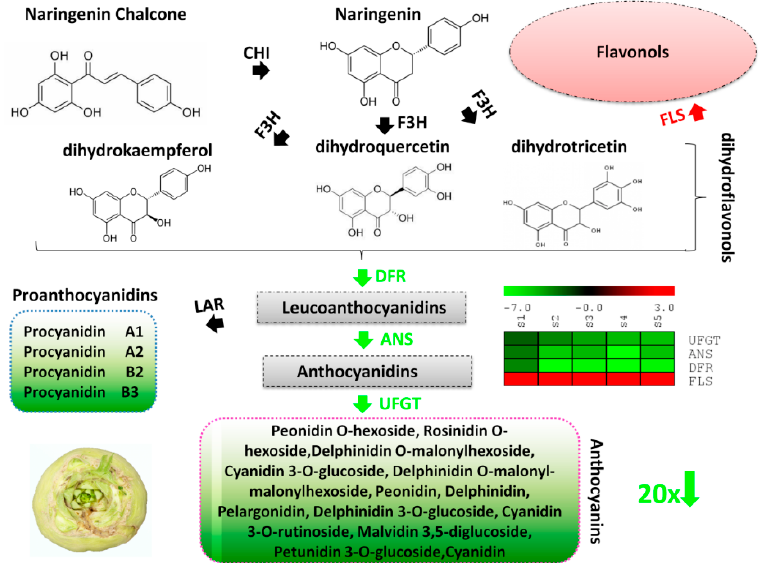
Figure 6. Proposed model of the mechanism leading to the low anthocyanin content in the green turnip (GT). Naringenin chalcone is isomerized by chalcone isomerase (CHI) to naringenin. Flavanone 3-hydroxylase (F3H) converts naringenin into dihydroflavonols (dihydrokaempferol, dihydroquercetin or dihydrotricetin). Then, the three dihydroflavonols are converted into colorless leucoanthocyanidins by dihydroflavonol 4-reductase (DFR) and subsequently to colored anthocyanidins by anthocyanidin synthase (ANS). Anthocyanidins are glycolsylated to facilitate their accumulation in cells by the enzyme flavonoid 3- O -glucosyltransferase (UFGT). Proanthocyanidins are generated by the action